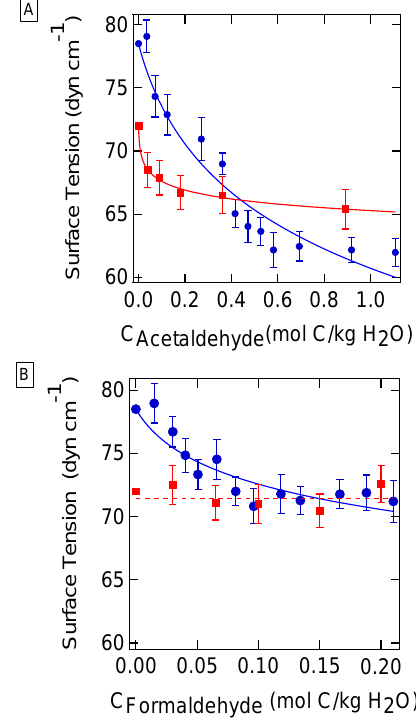
Fig. 1. Surface tension of solutions containing (A) acetaldehyde Figure 1. Surface tension of solutions containing (A) acetaldehyde and (B) formalde- and (B) formaldehyde in 3.1MAS (blue) and in water (red). The hyde in 3.1 M AS ( ● ) and in water ( ■ ). The curves shown are fits to the data using the curves shown are fits to the data using the Szyszkowski-Langmuir equation (Eq. 2). A linear fit (red dashed line) is shown for the Szyszkowski-Langmuir equation (Eq. (2)). A linear fit (red dashed line) is shown for formaldehyde-water data as a guide to the the formaldehyde-water data as a guide to the eye.